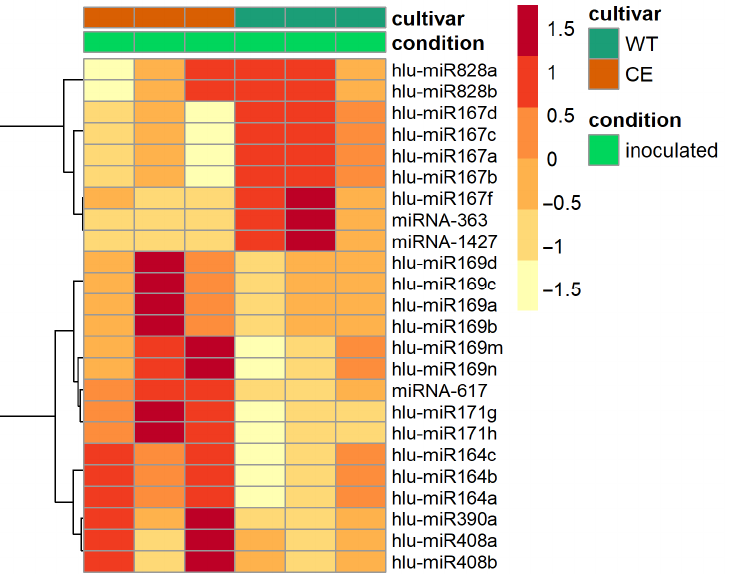
Figure 3. Heat map of differentially expressed miRNAs between the susceptible cultivar Celeia (CE) and the resistant cultivar Wye Target (WT) in response to inoculation with V. nonalfalfae . Clustering was performed using the Euclidean distance measure and Ward clustering method. The colour scale represents the z-score scaled by row of the control-normalized read counts.